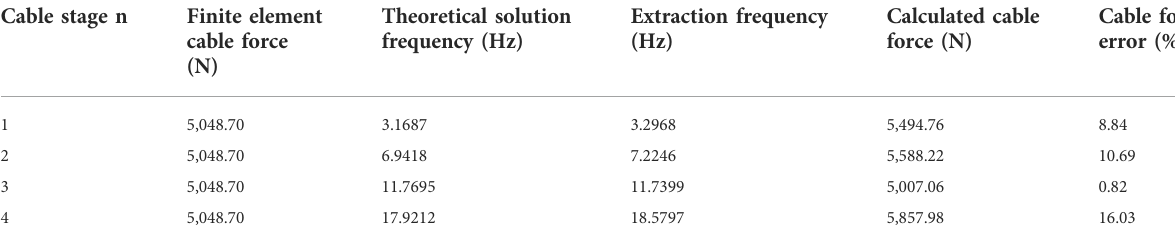
TABLE 4 Comparison of cable force results between extraction frequency and theoretical frequency. Cable stage